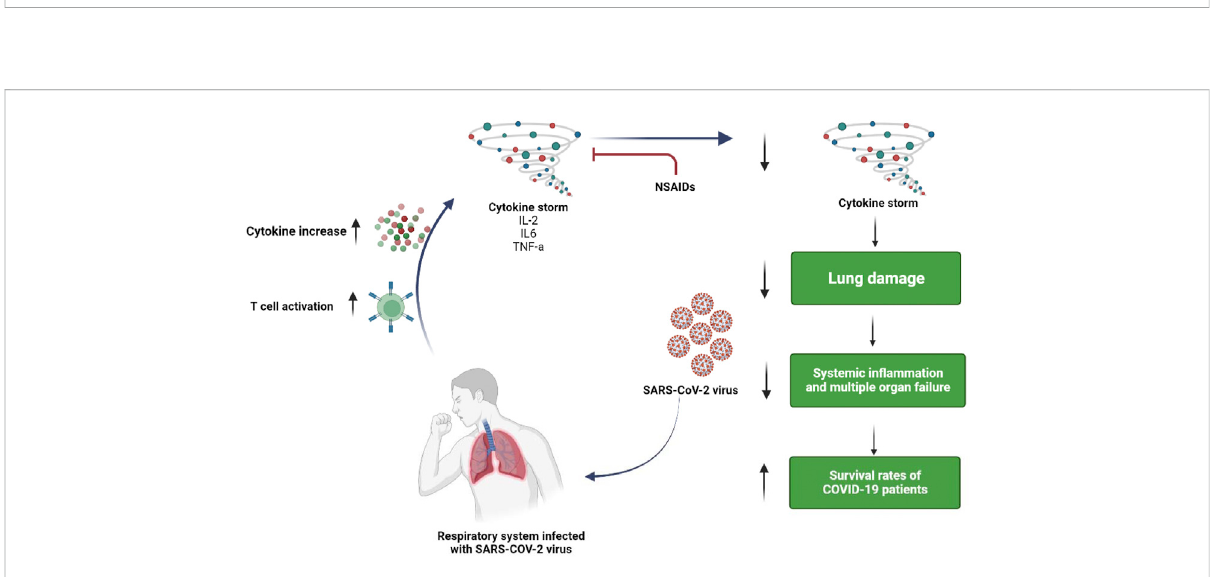
FIGURE 2 Possible mechanism of action of NSAIDs in the management of